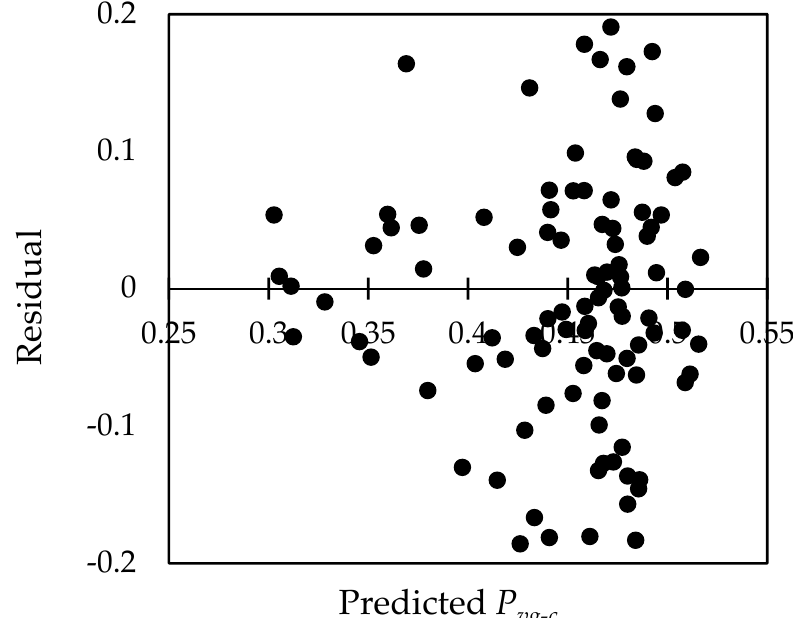
Figure 13. The residual plot of the estimated P vg-c and LAI.